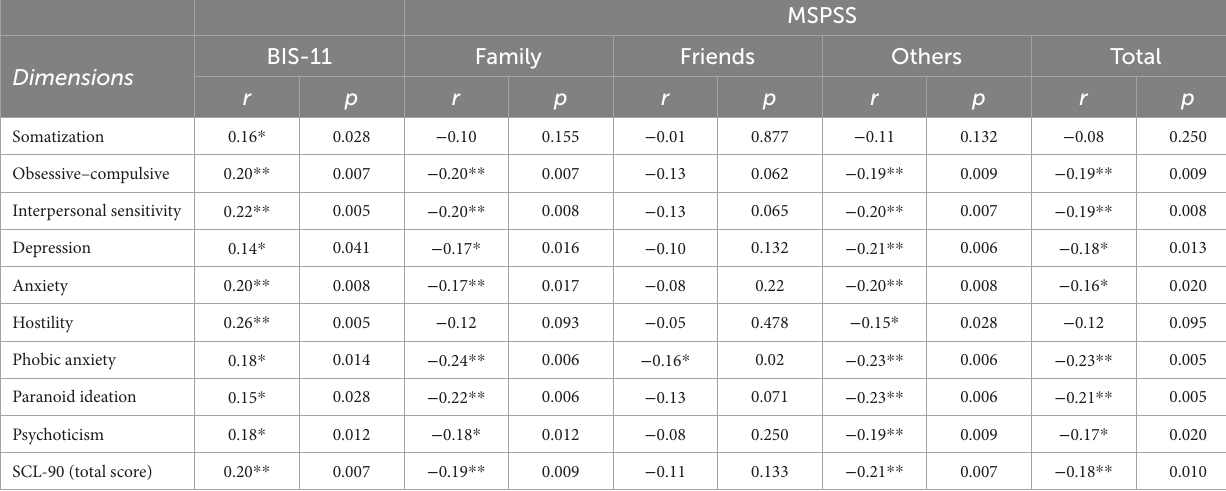
TABLE 3 The correlation of BIS-11, MSPSS, and respondents’ each dimension of SCL-90.